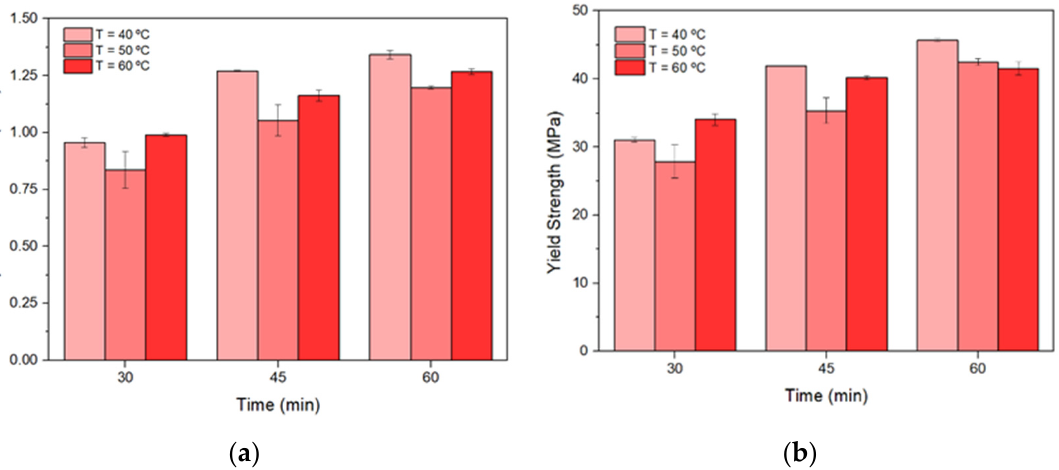
Figure 3. Obtained values on ( a ) compressive modulus and ( b ) yield strength by exposing all the printed cylinders to different curing settings.